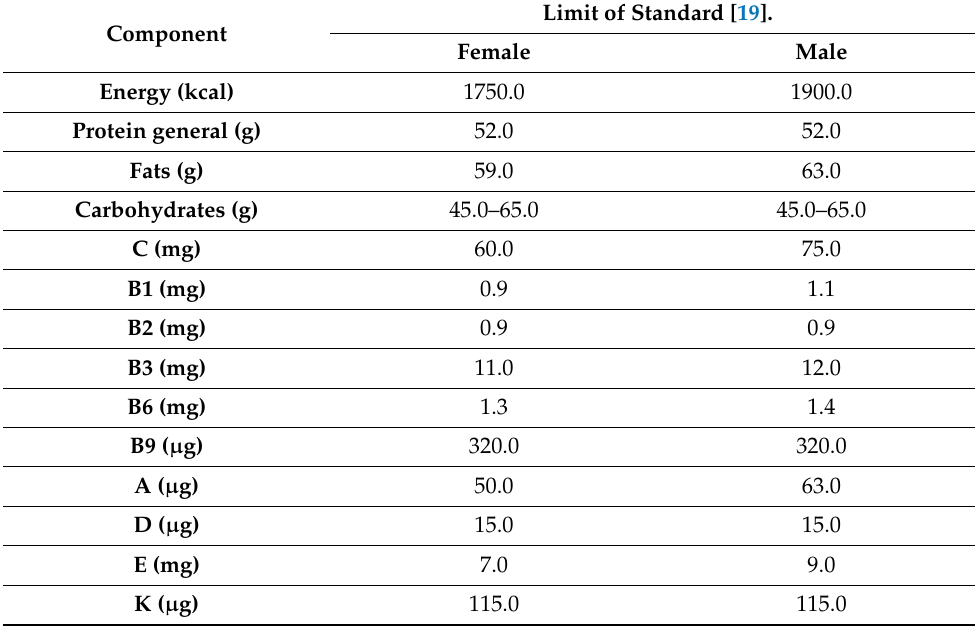
Table 1. Nutrition standards used in the